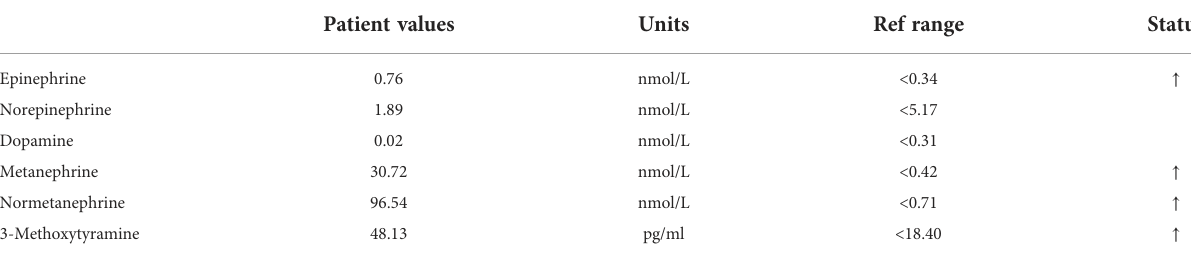
TABLE 1 Plasma metanephrines measurements con fi rming the pheochromocytoma